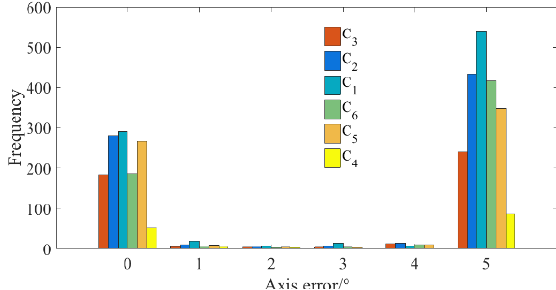
Figure 34. The UR5 robot’s axis errors.